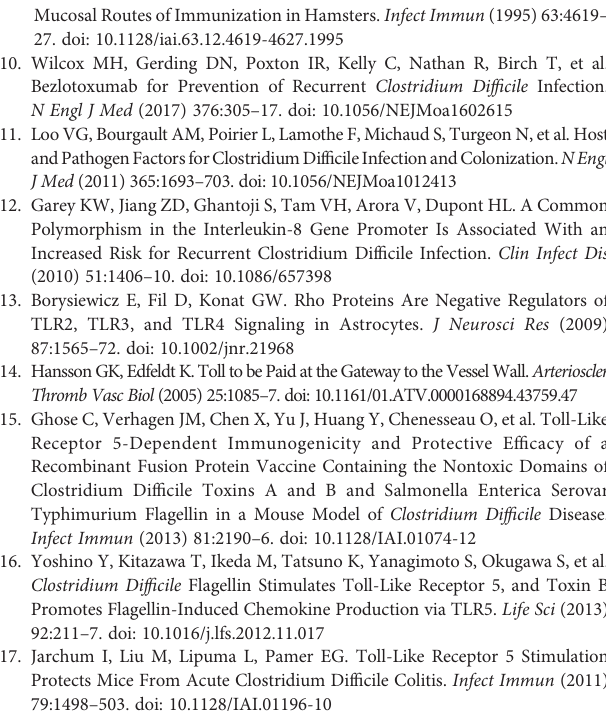
Supplementary Table 1 | Probe sequences used for detecting TLR2 and TLR4 polymorphisms. Supplementary Table 2 | Patient characteristics and recent medications of 539 patients with or without the development of CDI. Data are patient numbers (%), unless indicated. iv, intravenous; o, oral. Supplementary Figure 1 | Upon normalization to each treated genotype, the in fl ammatory responses were signi fi cantly increased in TLR2-de fi cient mice during CDI. Supplementary Figure 2 | (A) The original ZO-1 fl uorescent staining for each genetic background mouse without infection. (B) Disseminated aerobic and anaerobic bacteria in the livers of WT and TLR2-de fi cient mice were also assessed with or without infection. The disseminated bacteria were increased in TLR2 mice even without infection. Compared to the WT mice with/without infection group, the amount of bacteria translocated to other sterile organs was increased in TLR2- de fi cient mice, indicating that intestinal integrity was friable in TLR2 mice, especially during